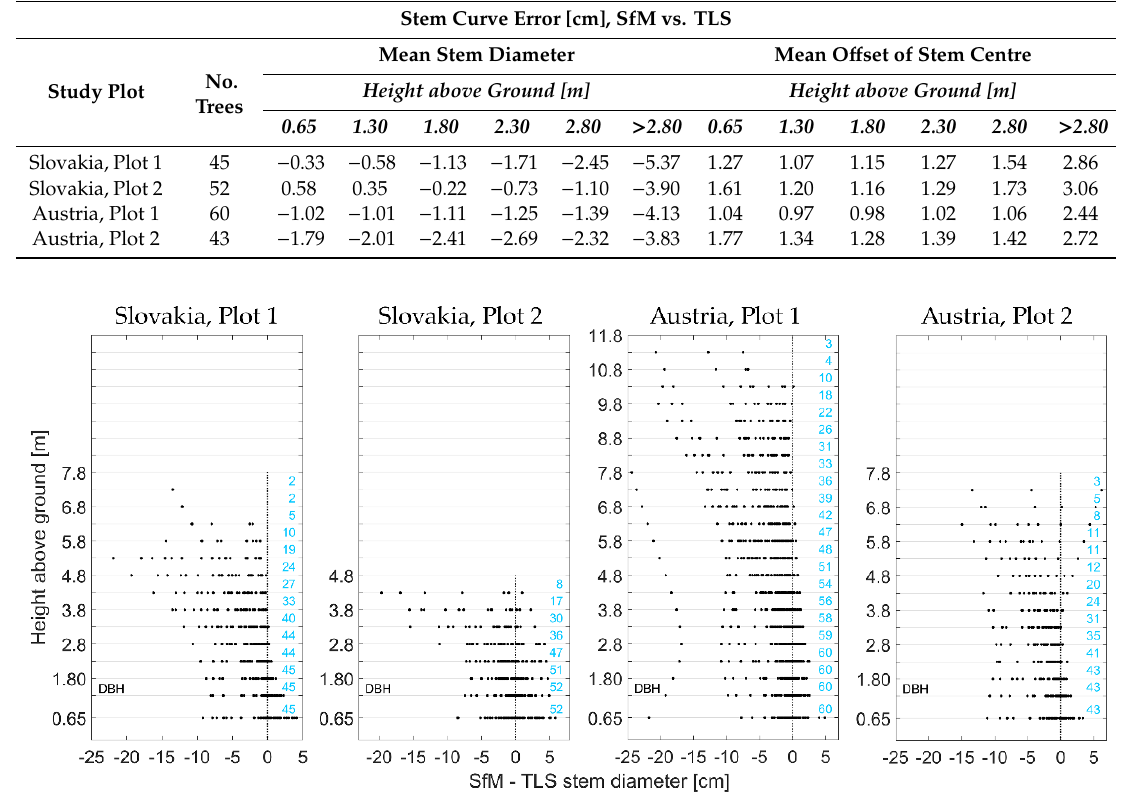
Figure 8. For each forest plot, the difference of the stem curve between SfM and TLS. In light blue, the number of estimated diameters for each height above the ground is shown.